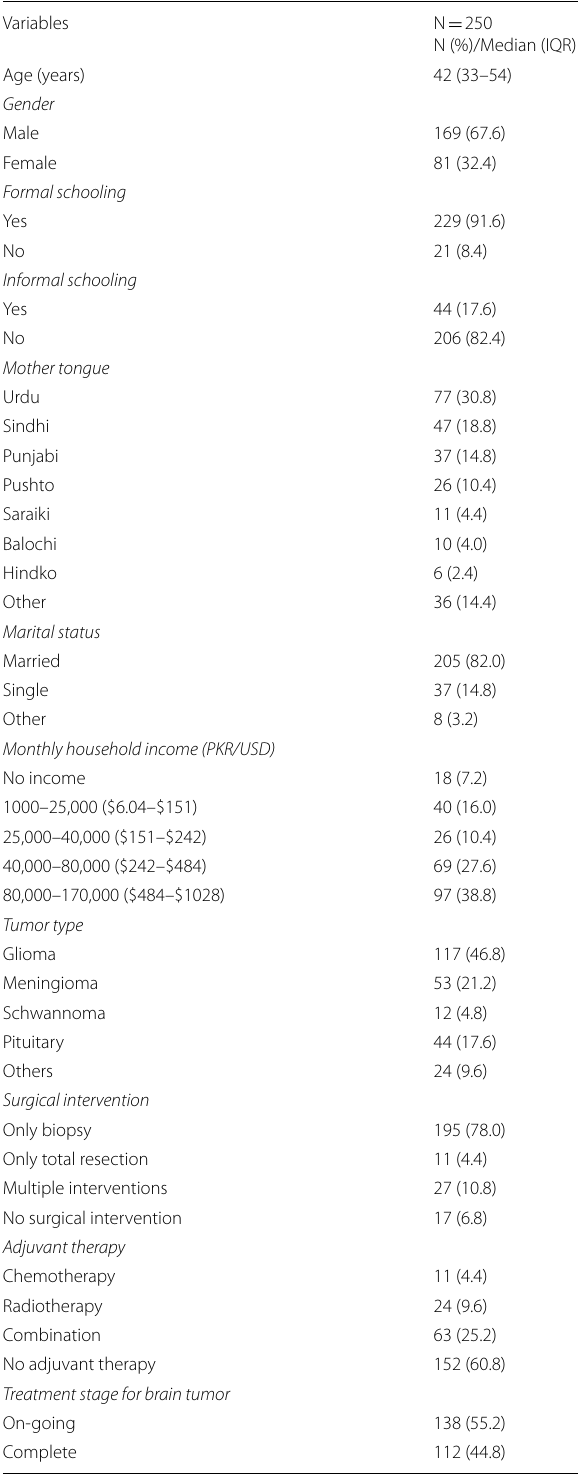
Table 1 Participant demographic characteristics and